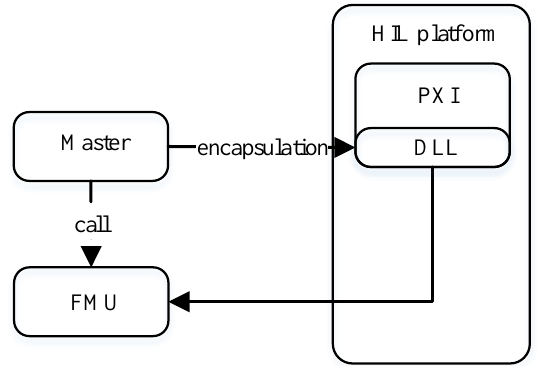
Figure 25. Schematic Diagram of FMU Integrated on HIL.